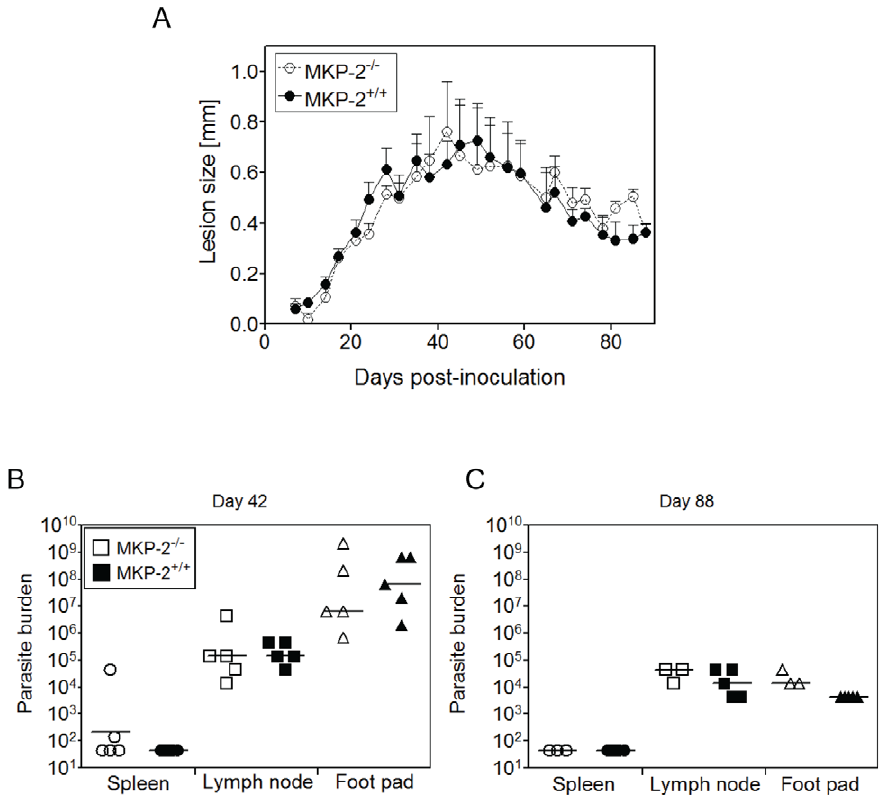
Figure 1. MKP-2 deficiency does not alter the course of infection with L.major . Ten MKP-2 2 / 2 (open symbols) and ten MKP-2 + / + mice (closed symbols) were given with 2 6 10 6 L. major promastigotes subcutaneously into the left hind foot pad. The right uninfected foot pad was used for reference. Lesion development was monitored by measuring the footpad thickness (A) over time using a dial gauge calliper. At peak of infection (day 42, B) and after the onset of healing (day 88, C) five mice were sacrificed at random and parasite burdens in foot pad, popliteal lymph nodes and spleens were determined using a limiting dilution assay. Detection limit was 65 for spleens and 6500 for lymph node and foot pads. Error bars are shown as standard error of the mean (SEM). The data shown is representative of at least three independent experiments.